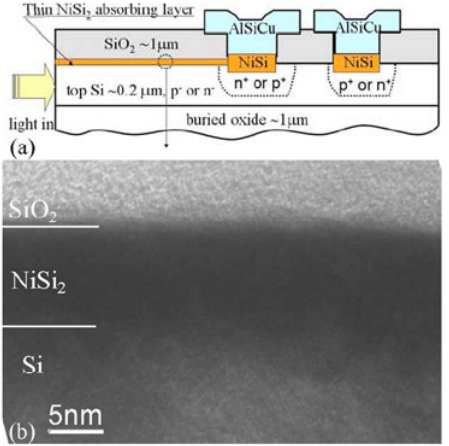
Figure 15. (a) Schematic structure of the waveguide-based silicide Schottky-barrier photodetector proposed by Zhu et al. ; (b) XTEM of the thin absorbing NiSi silicon waveguide [64]. Reprinted with permission from S. Zhu, et al . Copyright